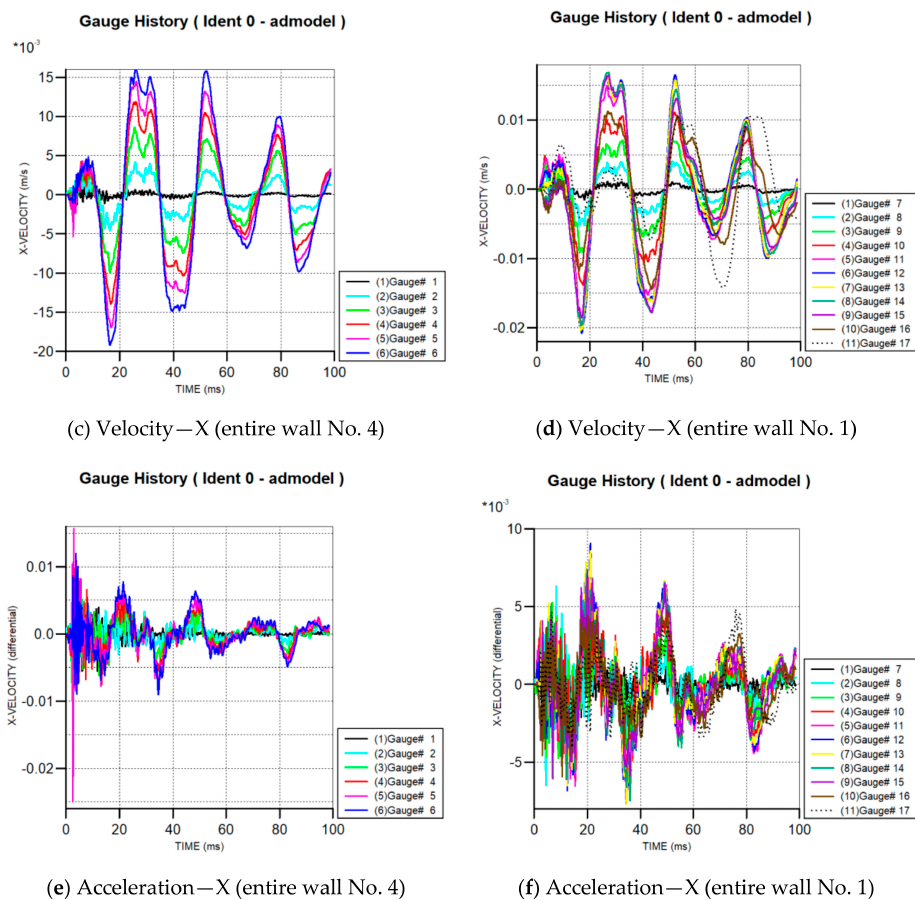
Figure 14. Displacement, velocity, and acceleration at certain sensors for Case